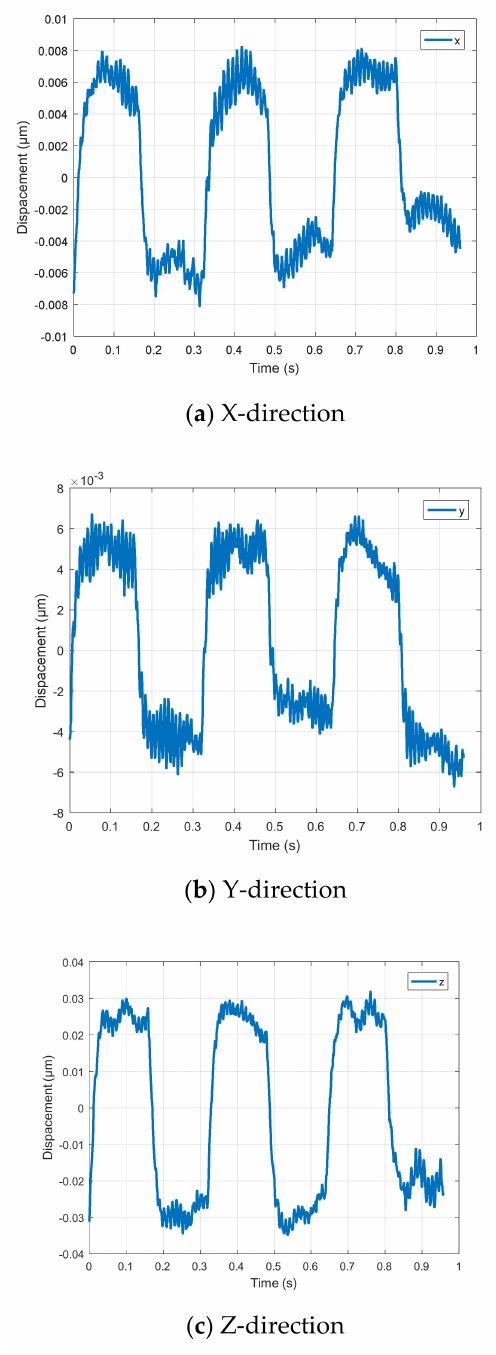
Figure 13. Precision test